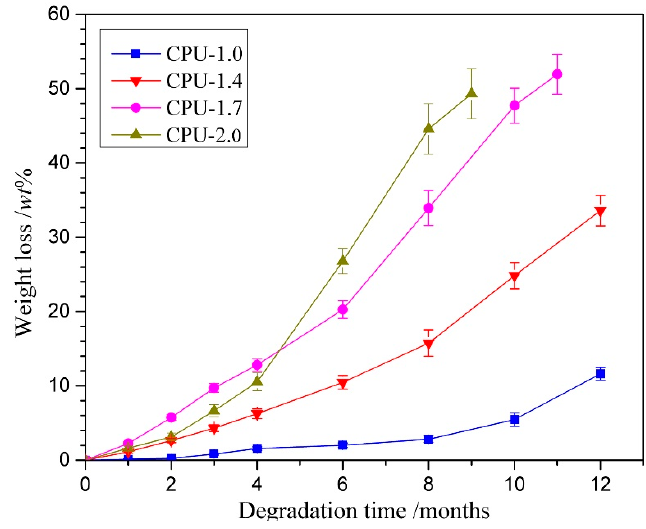
Figure 8. Degradation behaviors of CPU films with different COS content in PBS (pH: 7.4) at 37 ± 0.1 °C.